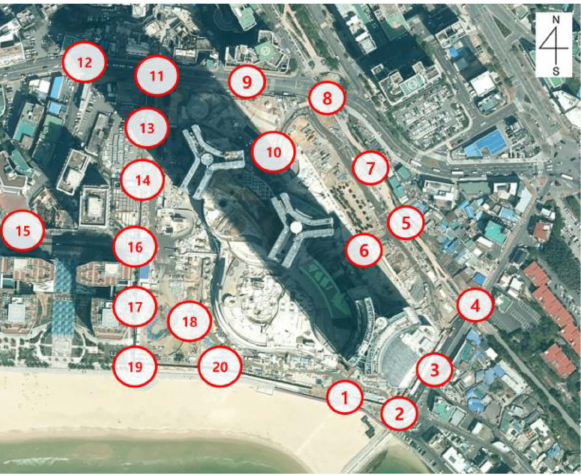
Figure 3. Field measurement points (1~20) around the LCT residential